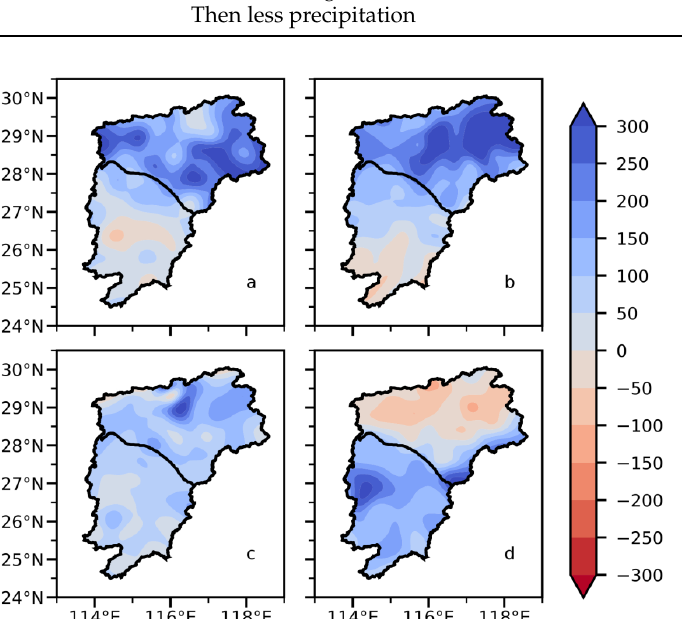
Figure 9. Summer precipitation anomaly in the Poyang Lake basin ( a ). Summer precipitation anom- aly under rule B in region I ( b ). Summer precipitation anomaly under rule D in region I ( c ). Summer precipitation anomaly under rule B in region II ( d ). Summer precipitation anomaly under rule D in the region